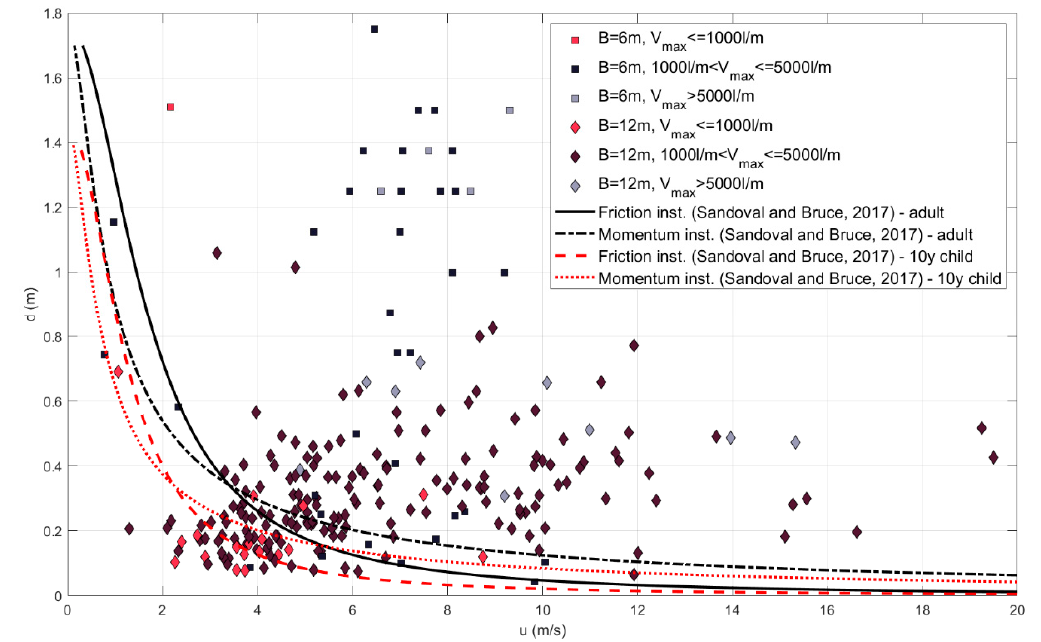
Figure 21. Flow depth versus velocity, comparison with Sandoval and Bruce (2017) curves, the discharges are divided for different promenades and maximum volumes.